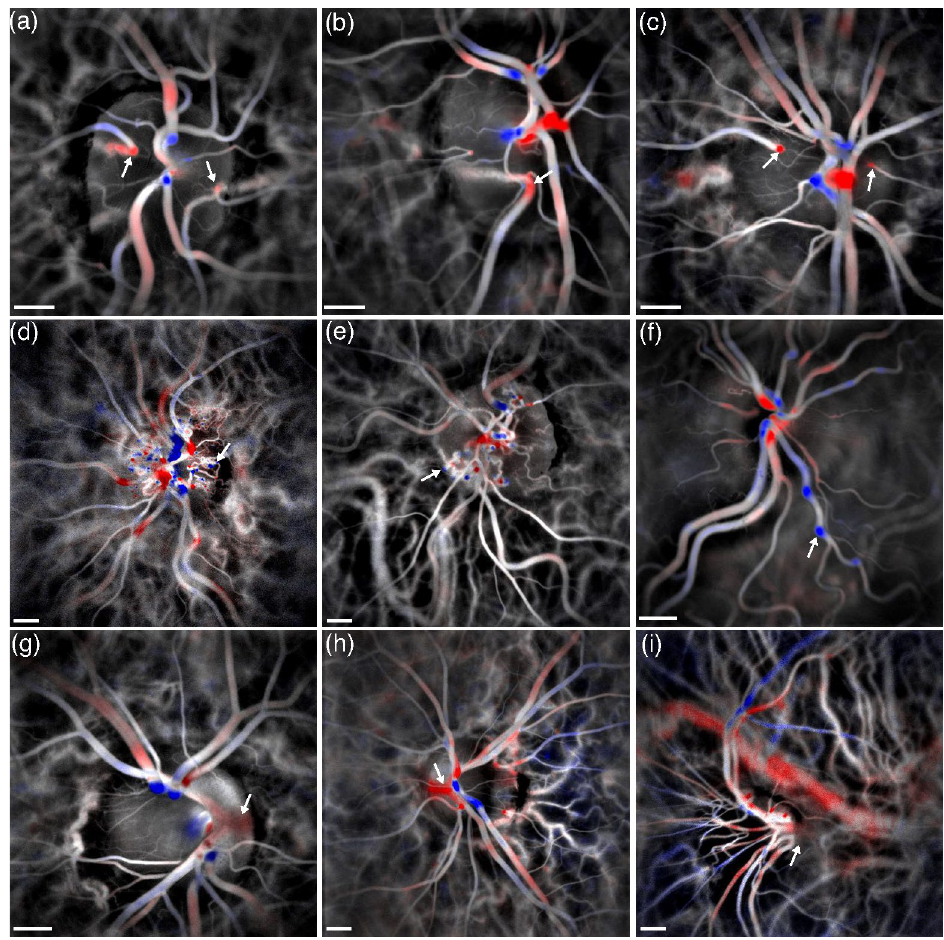
Figure 2. Examples of vascular structures revealed with the directional contrast. ( a – c ) Flow incoming from cilio-retinal arteries. ( d – f ) Axial tortuosity in collateral or large retinal vessels. ( g – i ) Abnormal inclination of the papilla and central retinal vessels (papillary dysversion). The estimated size of the scale bar is 500 µ m.